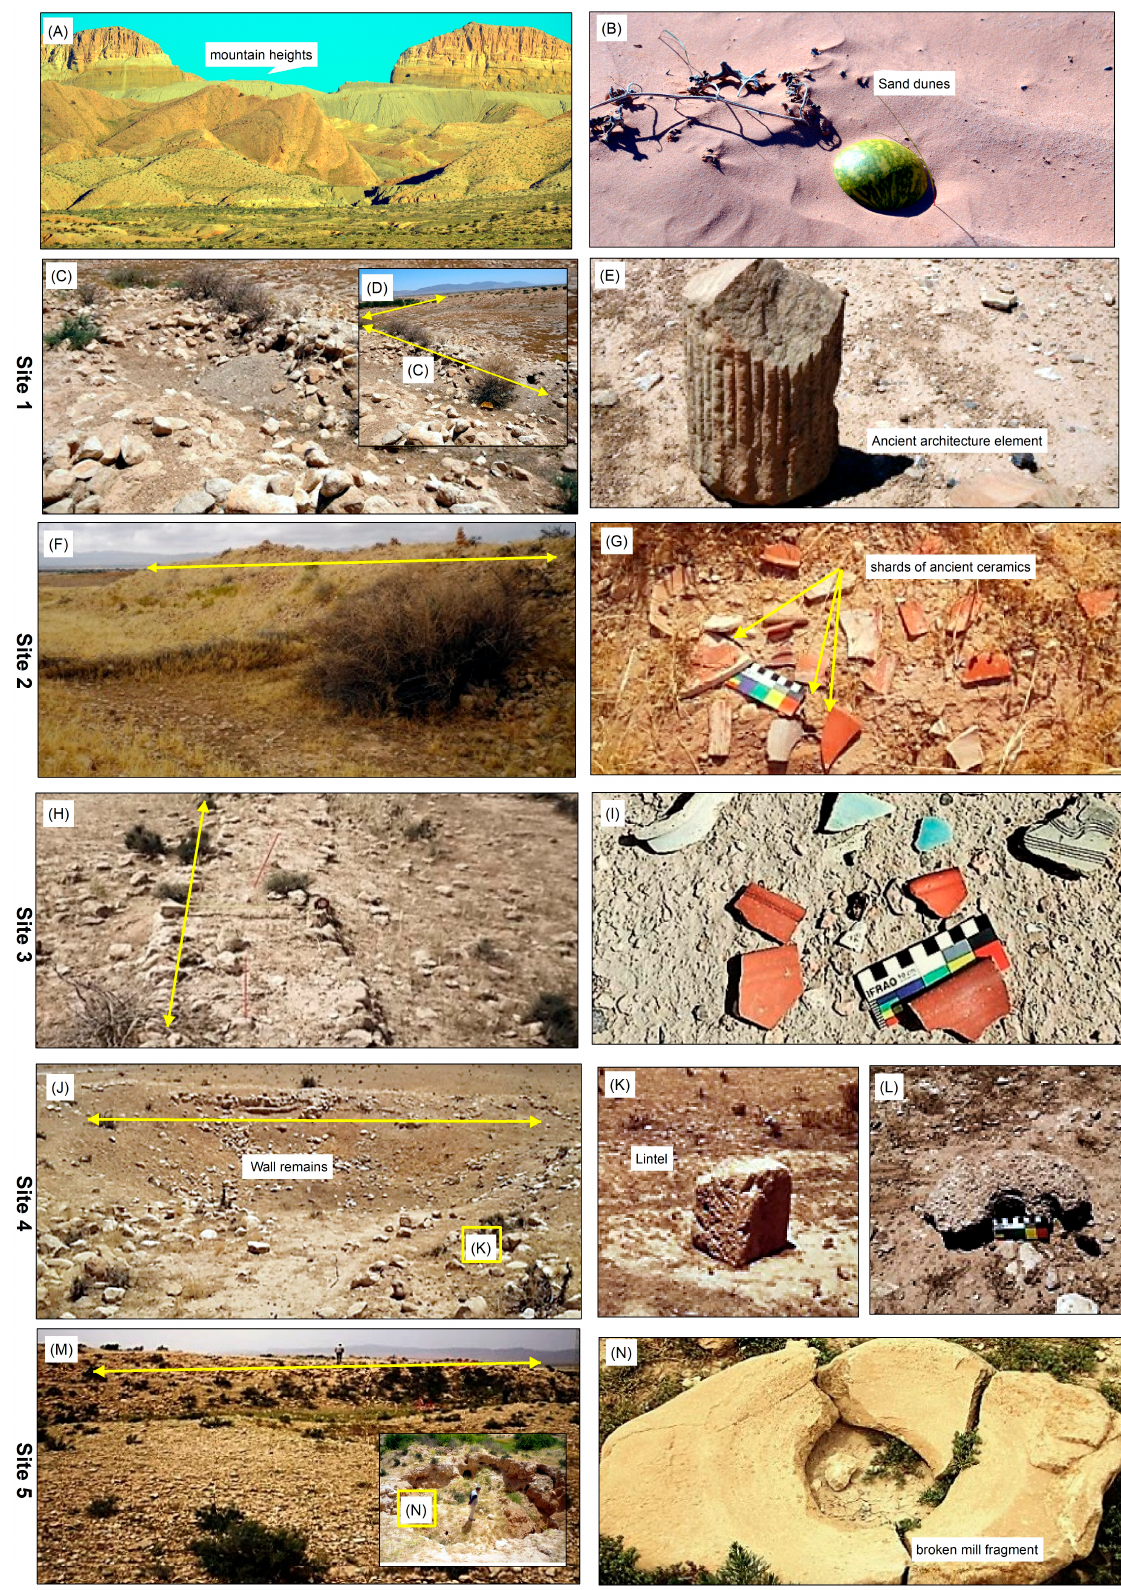
Figure 6. Magnified views of anomalies 1 to 5. ( A , B ) Landscape of the study area. ( G , I , N , L ) Shards of ancient ceramics. ( E ) Ancient Architectute element ( K ) Lintel photographed at the entrance to a fortress. ( C , D , F , H , J , M ) Field photos of wall remains.